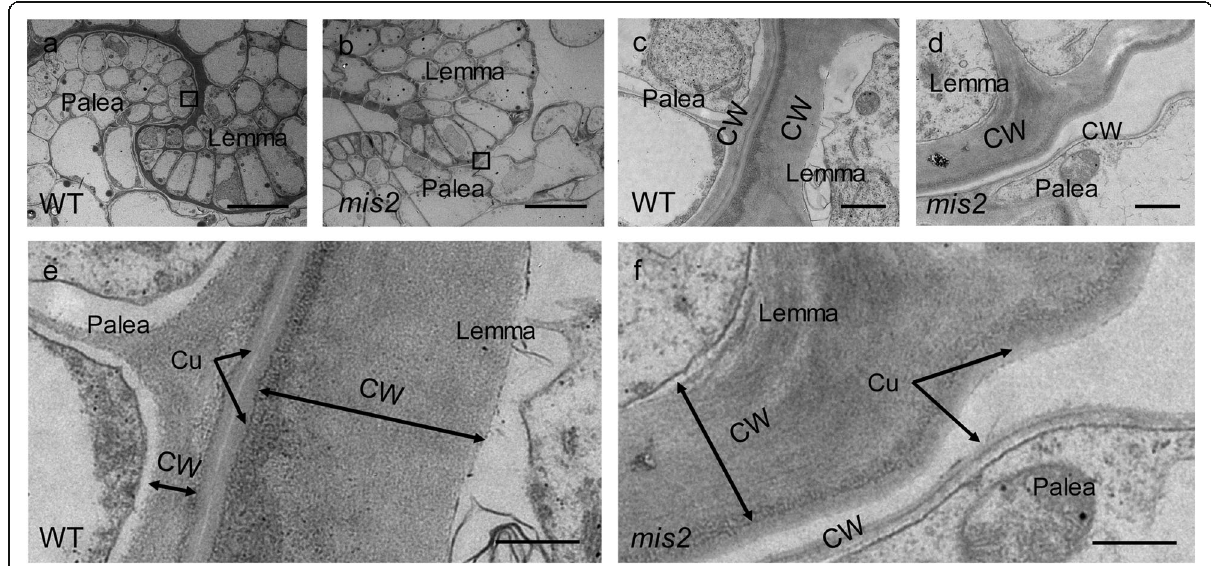
Fig. 4 Comparison of the interlocking cells, cell wall and cuticle layer between WT and mis2 . ( a , b ) Transmission electron micrographs (TEM) for the interlocking cells of the palea and lemma in the WT and mis2 . Bar =10 μ m. ( c, d ) Magnified views of the boxed region in ( a , b ), respectively. Bar =5 μ m. ( e , f ) Cuticle and cell wall of interlocking cells in the WT and mis2 . Bar =1 μ m. Cu, cuticle; CW, cell